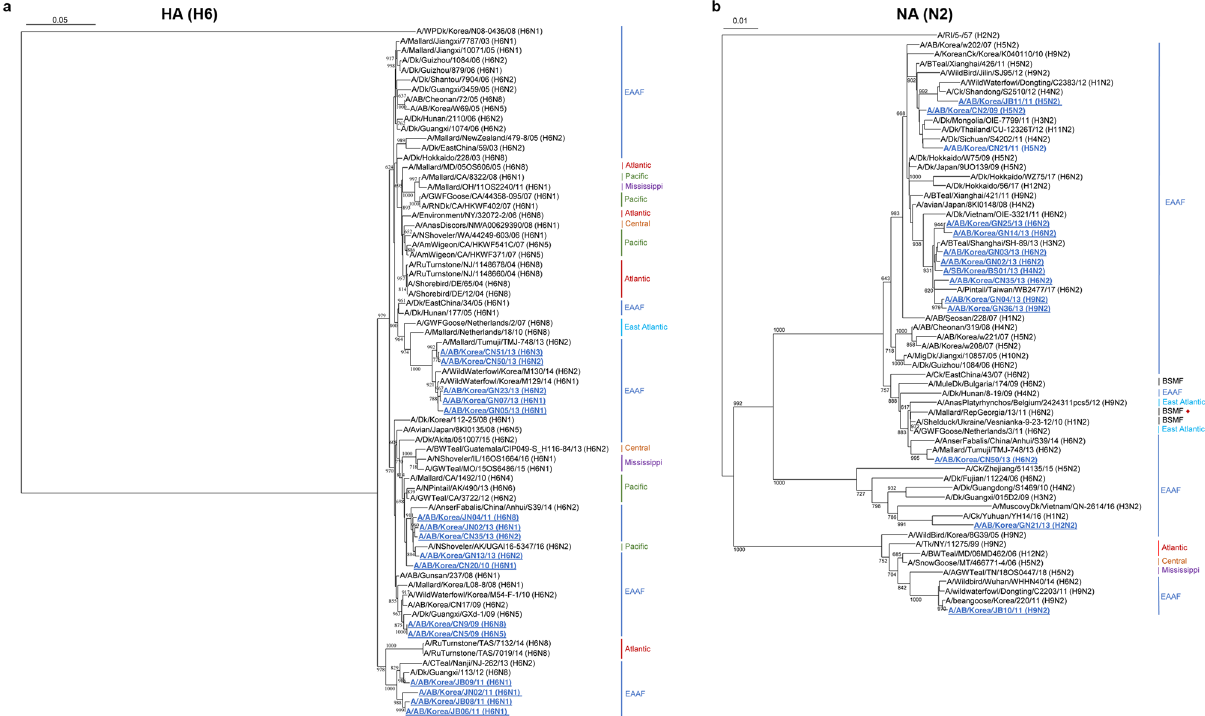
Figure 3. Phylogenetic analyses of representative H6- and N2-subtype avian influenza fecal isolates in South Korea in 2009–2013. The assembled ( a ) H6-subtype hemagglutinin and ( b ) N2-subtype neuraminidase coding sequences of representative isolates (blue, underlined) were compared to different isolates from various locations. Wildfowl migratory flyways that cover these locations are indicated. Bootstrap values ≥ 600 are shown. BSMF Black Sea-Mediterranean flyway, EAAF East Asian-Australasian flyway. Red diamond: the Republic of Georgia is at the intersection of the BSMF, Central Asian, and East Africa-West Asian